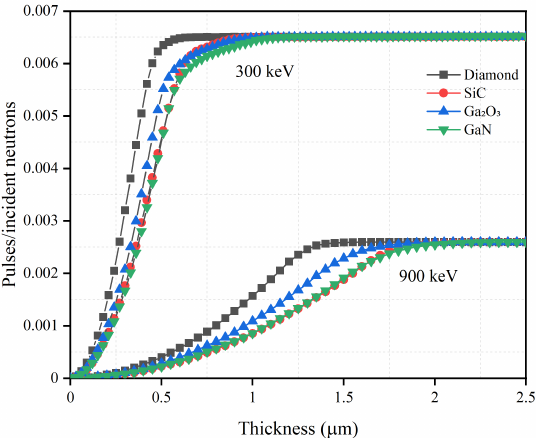
Figure 3. Neutron detection efficiency versus semiconductor material thickness with optimal B 4 C converter layer thickness for diamond, SiC, Ga 2 O 3 and GaN semiconductor materials. The optimal converter layer thicknesses are 2.6 µ m for 300 keV LLD and 1.7 µ m for 900 keV LLD, as shown in